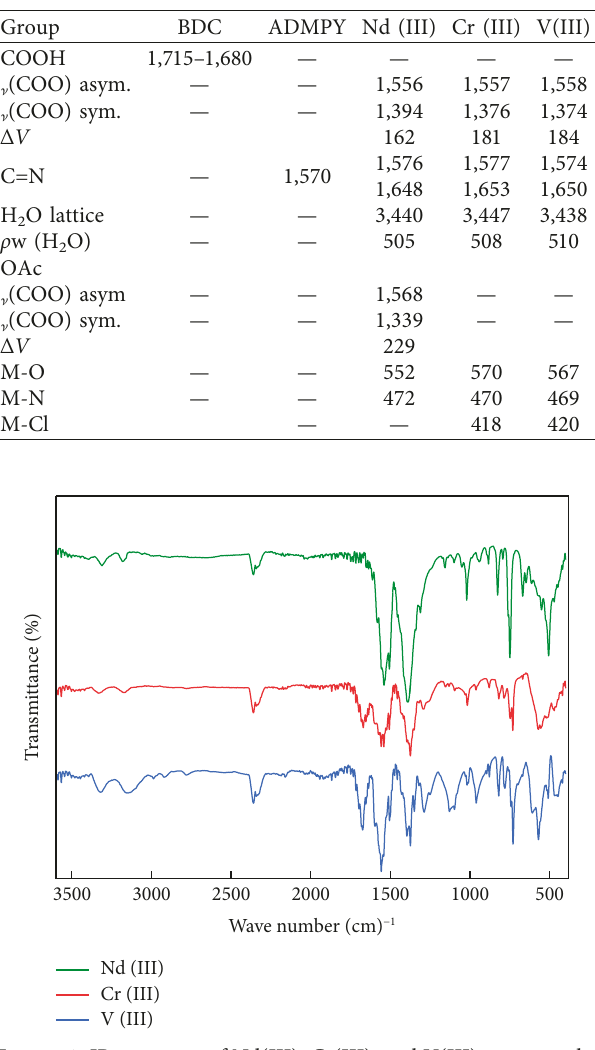
Figure 1: IR spectrum of Nd(III), Cr(III), and V(III)